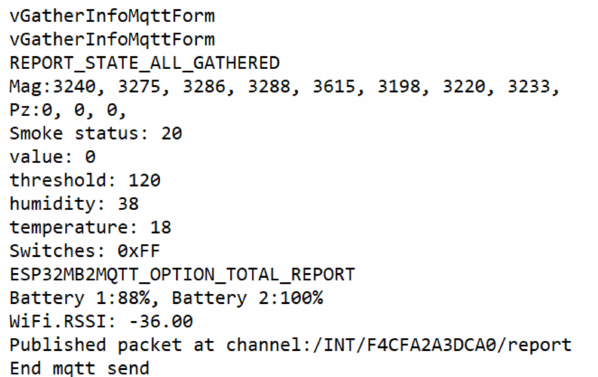
Figure 9. RMC serial monitor report demonstrating the values read for the various